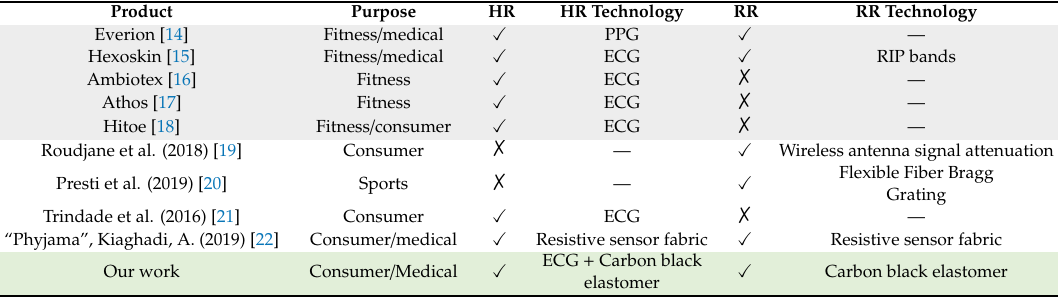
Table 1. Summary of the current state-of-the-art vital monitoring wearables and internal technology. ECG: electrocardiogram, HR: heart rate, PPG: peaks of finger measurement, RR: respiratory rate.